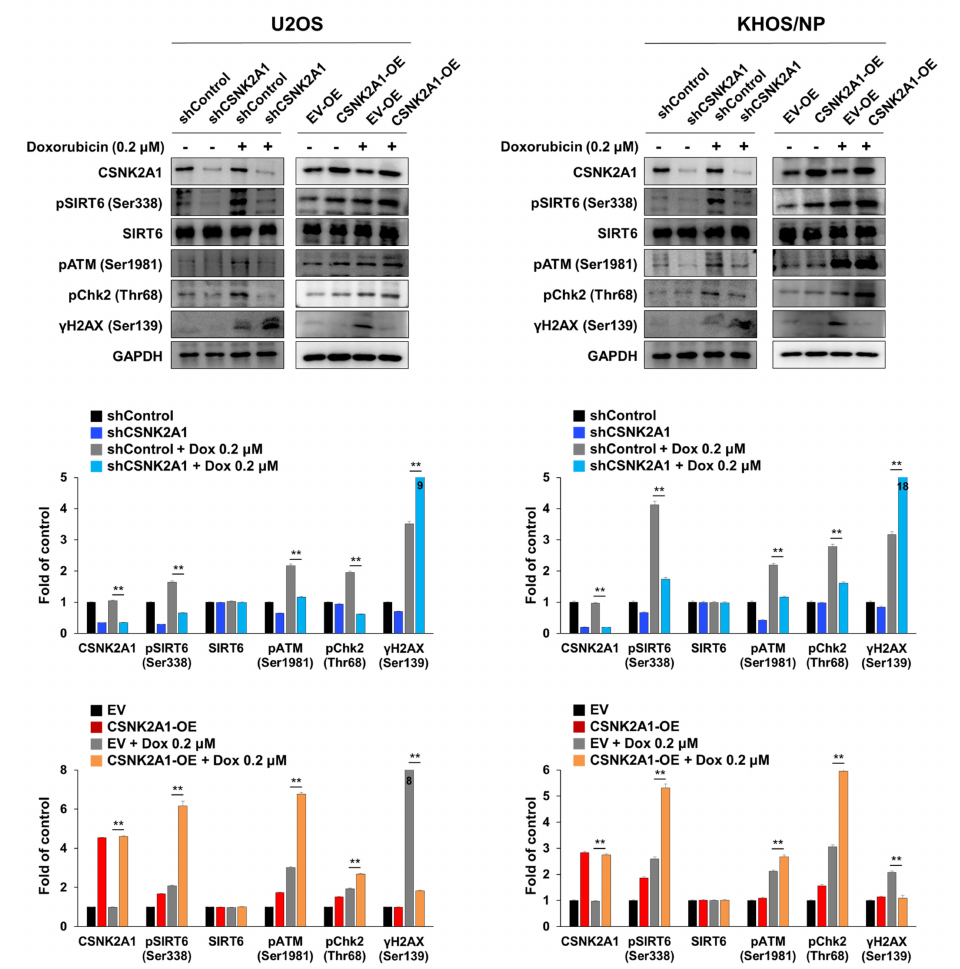
Figure 6. CSNK2A1 involvement in doxorubicin resistance through the SIRT6-mediated activation of the DNA damage repair pathway, shown using Western blot analysis. U2OS and KHOS/NP cells were transfected with control shRNA, shRNA for CSNK2A1, empty vector, or WT-CSNK2A1 and treated with DMSO or 0.2 µ M doxorubicin. Western blots for CSNK2A1, SIRT6, phosphorylated SIRT6 (pSIRT6, Ser338), phosphorylated ATM (pATM), phosphorylated Chk2 (pChk2), phosphorylated H2AX ( γ H2AX, ser138), and GAPDH were performed, and the density of the bands was measured in triplicate by using ImageJ software. **; p <